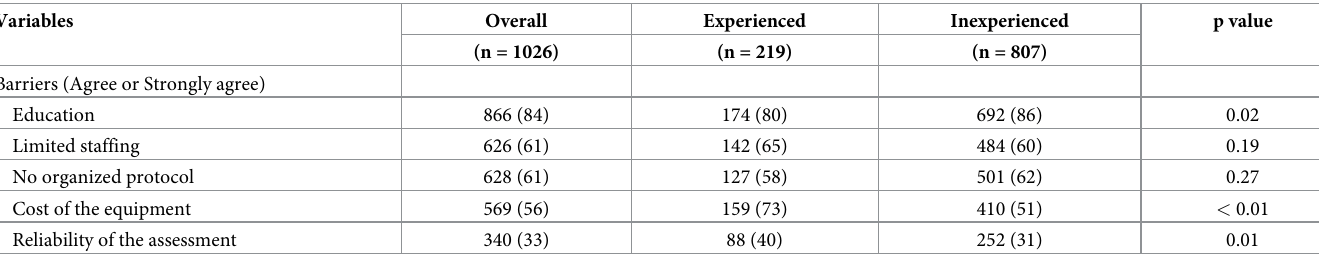
Table 3. Differences in ultrasound-based assessment between experienced and inexperienced participants.